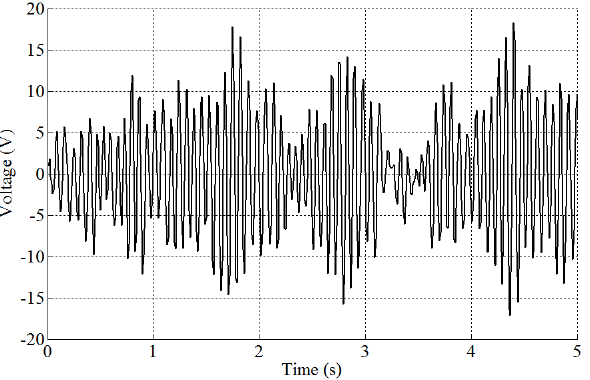
Figure 8: Control voltage variation under random excitation